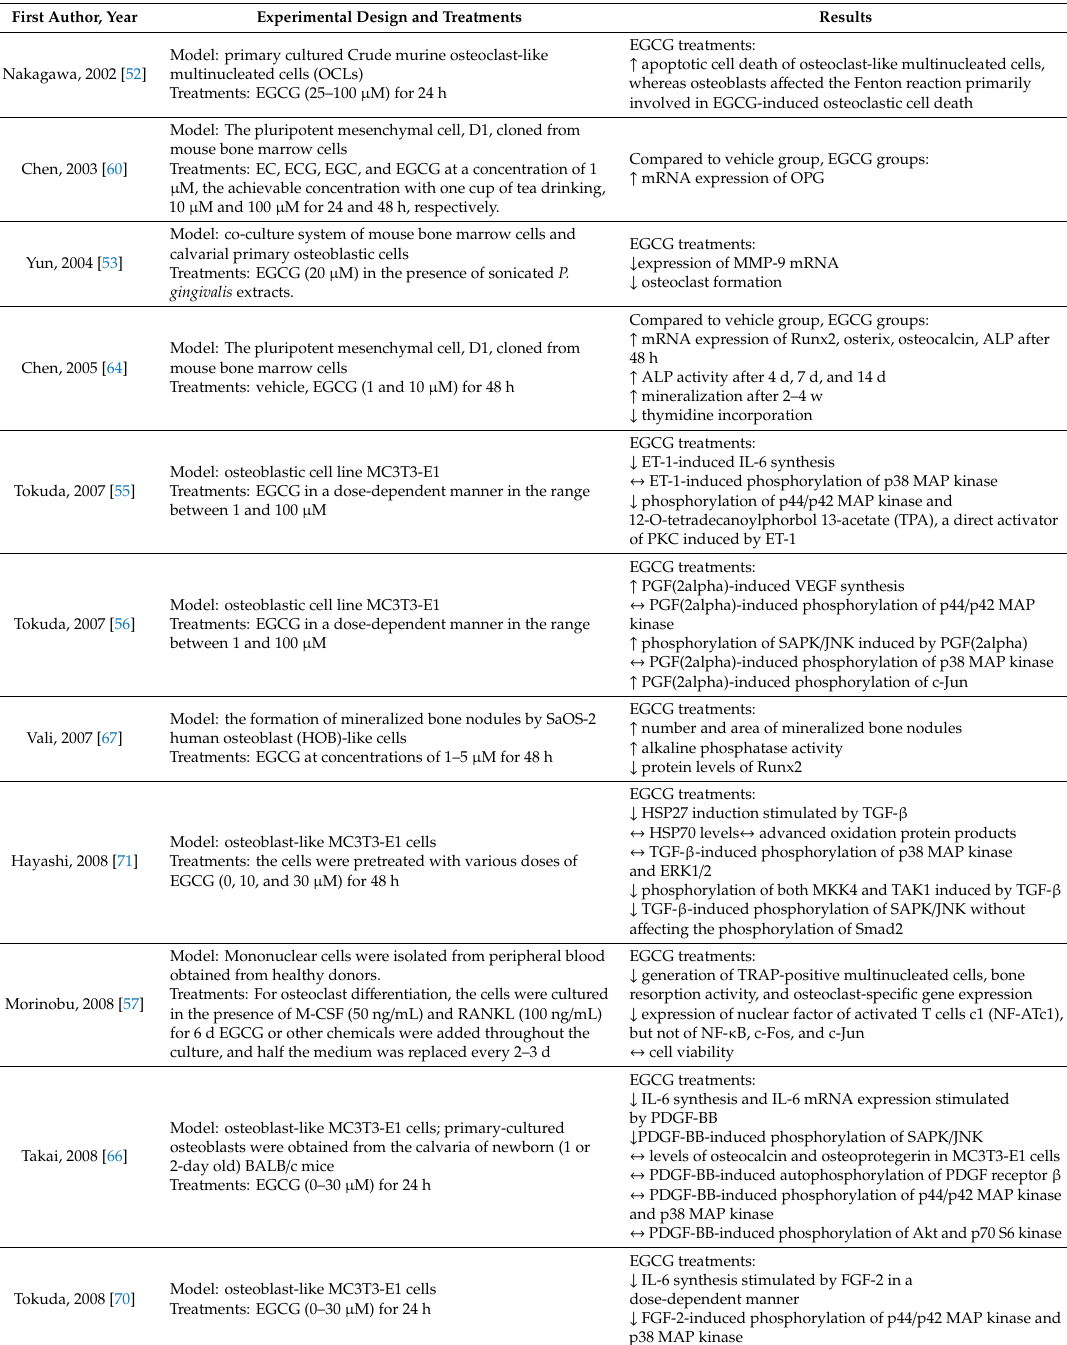
Table 1. In vitro e ff ects of